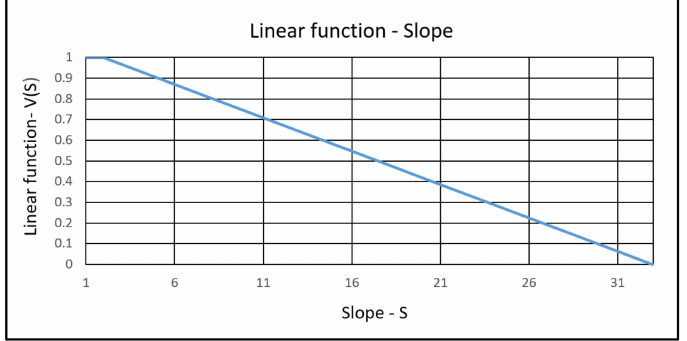
Figure 9. The graph of the linear slope function. Standardized slope values are hereinafter referred to as S ’ j